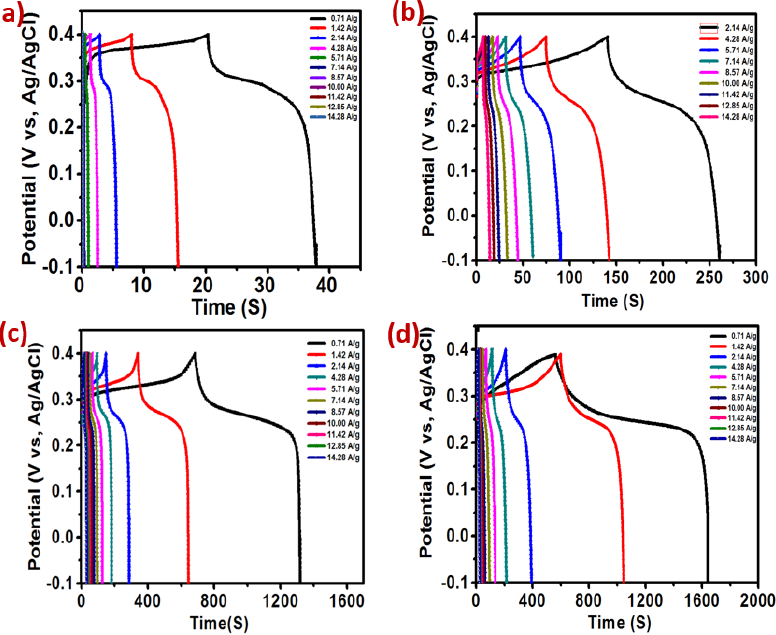
Figure 6. GCD curves of ( a ) Z ( b ) ZN ( c ) ZNP and ( d ) ZNPM at different current densities. A comparison of the GCD curves of Z, ZN, ZNP and ZNPM electrodes at 5 mA were shown in Figure S2. At a low current density of 5 mA, the specific capacitance of Z, ZN, ZNP and ZNPM were approximately 24.77, 919.44, 1716.08, and 2072.52 F g − 1 , respectively. A specific capacitance of four